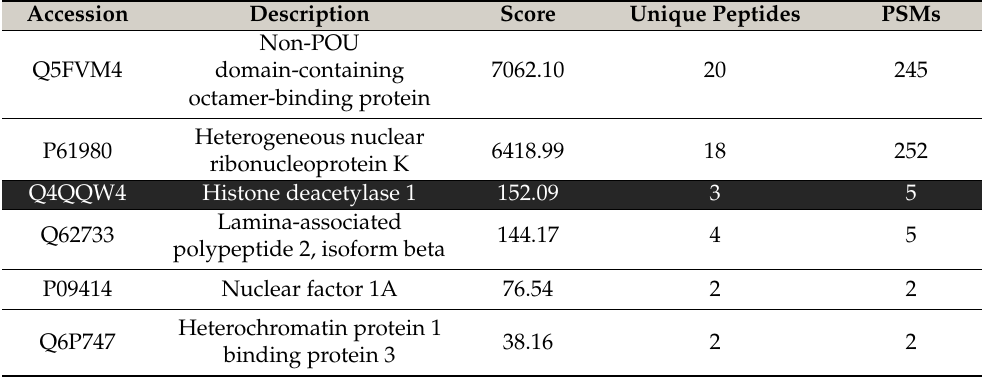
Figure 4. DNA affinity purification for mass spectrometry analyses. Proteins associating to the biotinylated OL2 DNA were affinity purified from FRSK nuclear extracts by avidin beads and separated with 5% sodium dodecyl-sulfate-polyacrylamide gel electrophoresis (SDS-PAGE). OL2 DNA affinity-purified protein bands (APP1 and APP2) are indicated with arrowheads. Table 1. Mass spectrometry analyses data of protein (APP1) purified through Biotin-OL2 DNA beads. Histone deacetylase 1(HDAC1) highlighted with white text on black background.